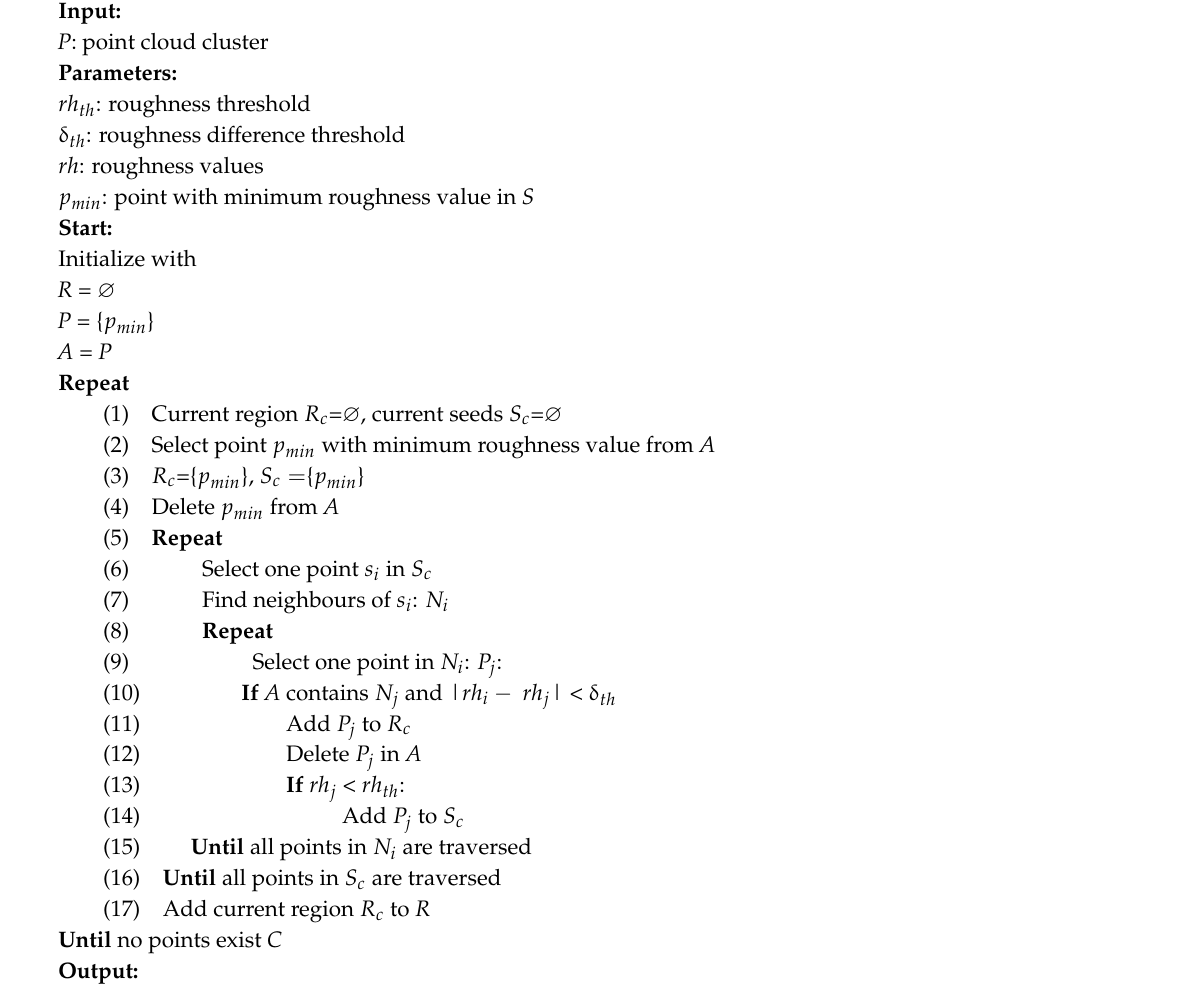
Algorithm 3 Region growing based on